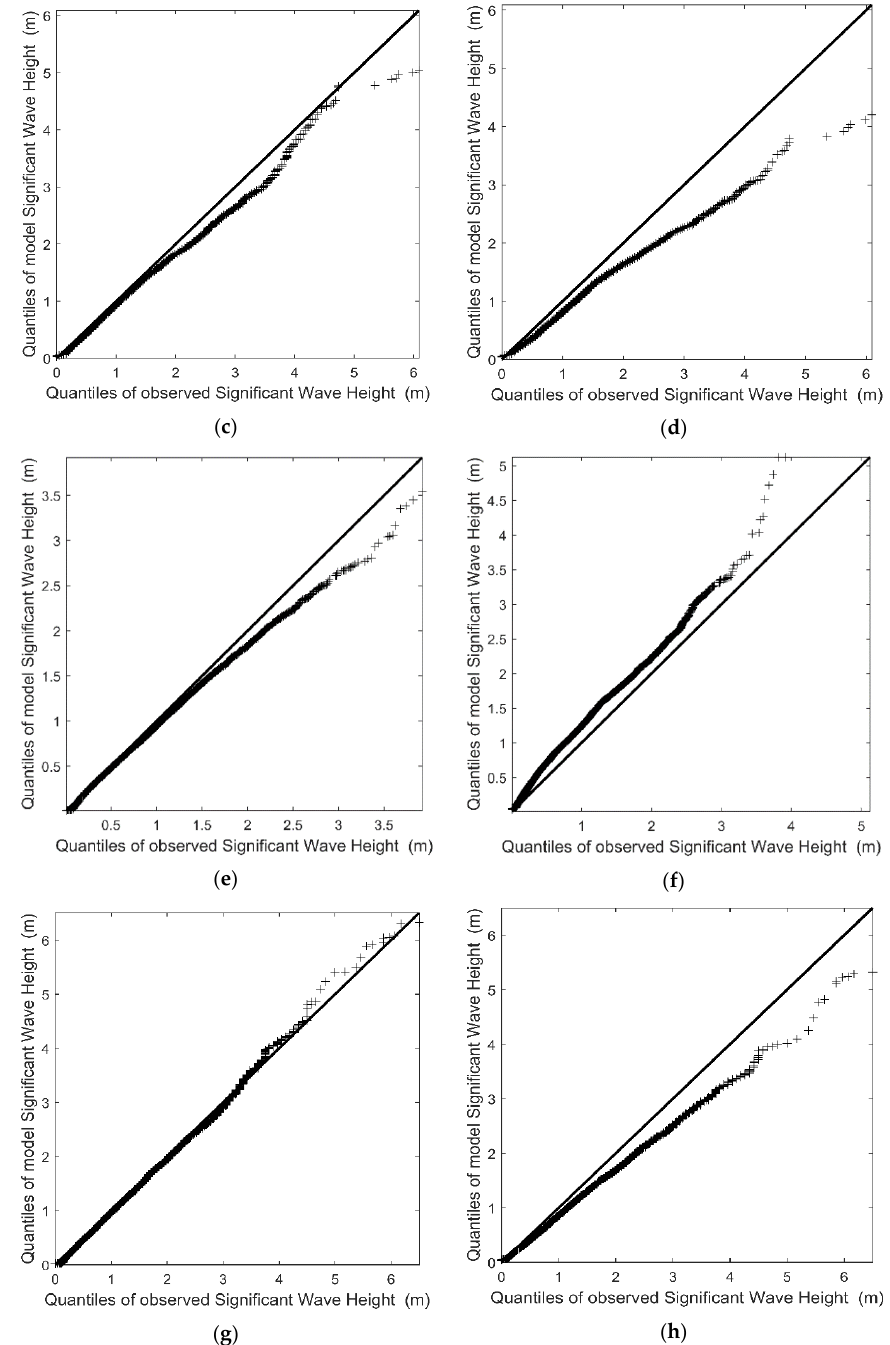
Figure 14. Q-Q plots of significant wave heights of the wave hindcast ( left column ) or ERA5 dataset ( right column ) against the Bastia (no. 3), Capo Mele (no. 5), Castiglione (no. 6), Giannutri (no. 8) buoys. Horizontal and vertical axes report observed and modelled data, respectively.